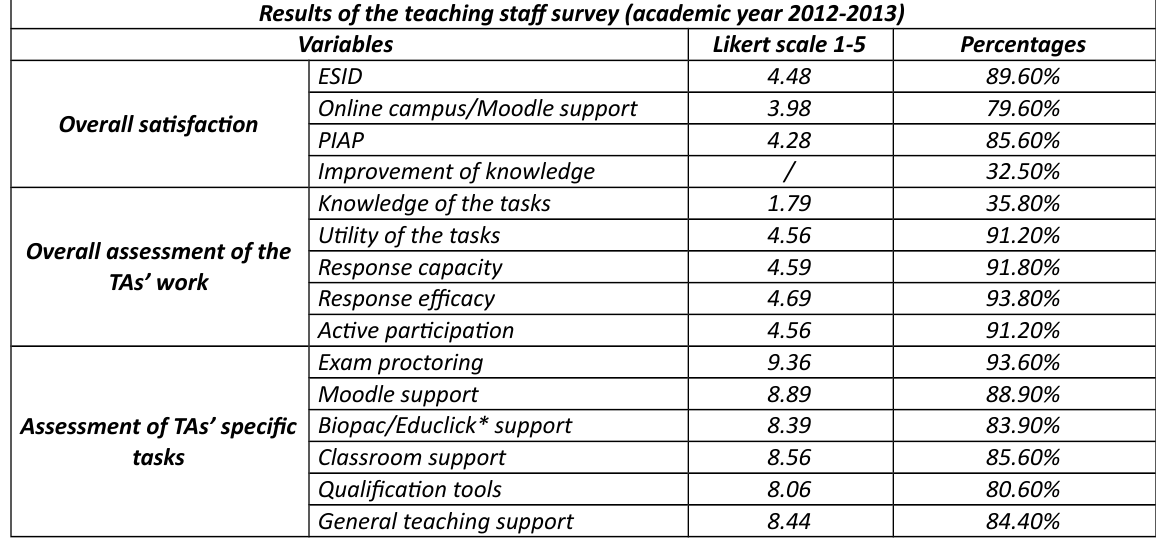
Table 1. The frst two main rows correspond to overall tasks and percepton of the quality of the work carried out in the ESID. The third row represents each specifc task. The column “Likert scale” represents the direct score obtained from the survey (out of 5 or 10 points), whereas the last column represents the percentage score used